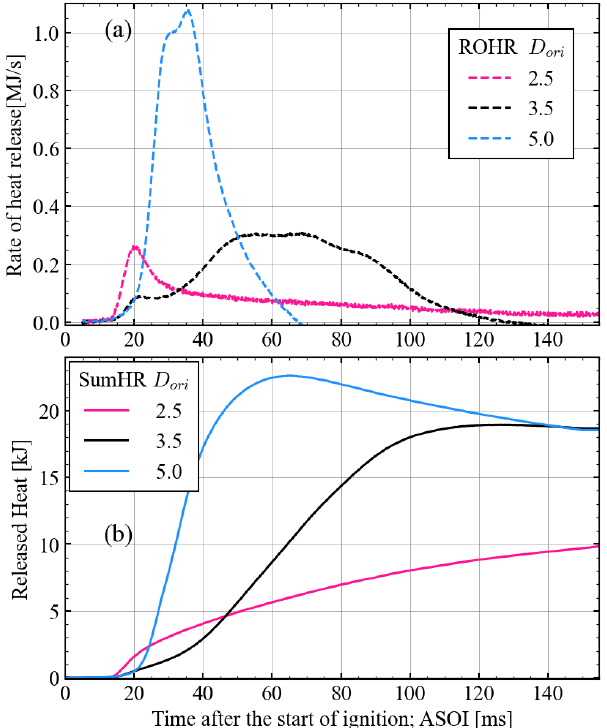
Fig. 18. Time history of (a) ROHR, and (b) of different orifice diameter (D ori = 2.5, 3.5, 5.0 mm) under “combustible”